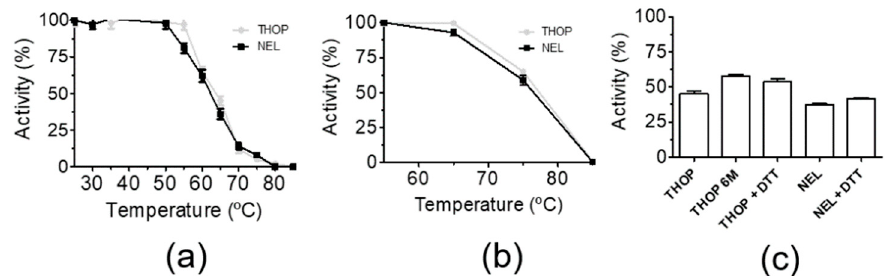
Figure 2. Thermostability of in solution and agarose-immobilized rTHOP and rNEL. Recombinant enzymes were preincubated for 20 min at each temperature in activity buffer ( a ) in solution or ( b ) immobilized in 1% agarose, indicating the positive effect of agarose in enzyme stability. The effect of the reducing agent DTT and THOP cysteine mutant (6 M) was also observed in solution (without immobilization) at the fixed temperature of 65 °C ( c ), suggesting that the increase in stability observable in ( b ) is mainly due to immobilization and not to enzyme oligomerization or other protein–protein interactions. Activities of both THOP and NEL were accessed by using the fluorogenic substrate Abz-GFSPFRQ-EDDnp (5 µM) in Tris-NaCl buffer at 37 °C in a spectrofluorimeter Hitachi F7000.